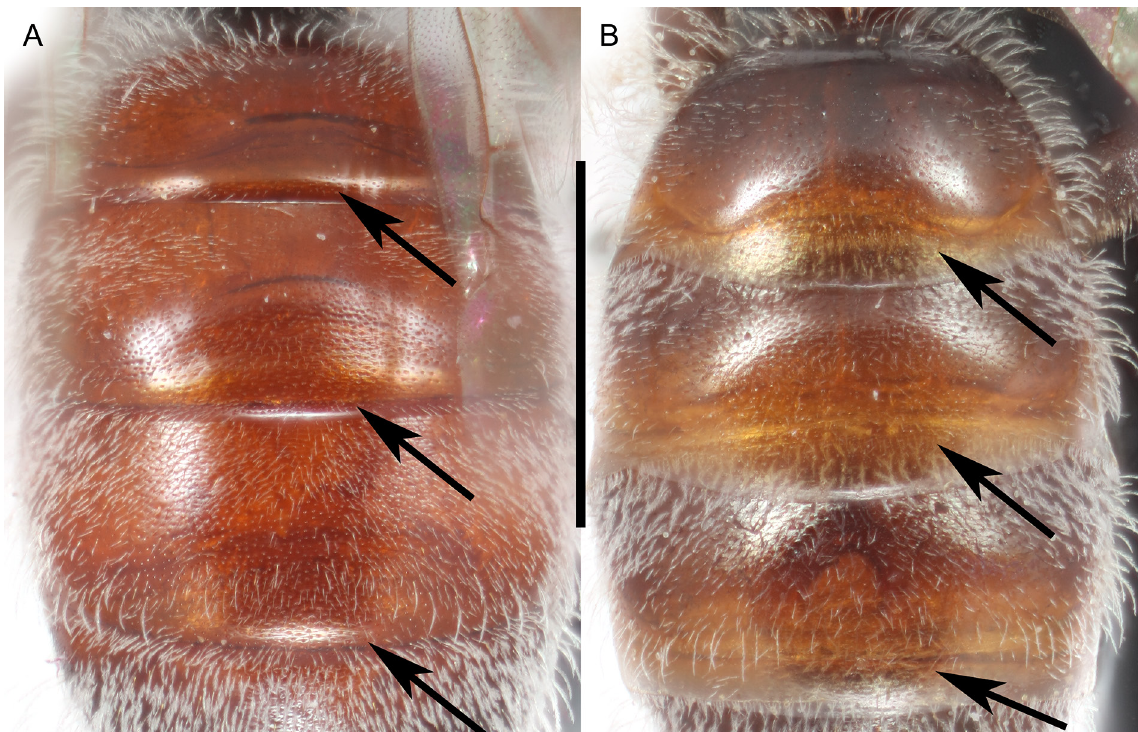
Fig. 97. T1–3. A . Lasioglossum ( D. ) cactorum sp. nov., ♀, with very narrow and abruptly downcurved apical rims and dense apical hair fringes. B . L. ( D. ) miltolepoides sp. nov., ♀, with broad, flat, slightly depressed apical rims and sparse apical hair fringes. Arrows point to approximate lengthwise center of apical rims. Scale bar: 1 mm.